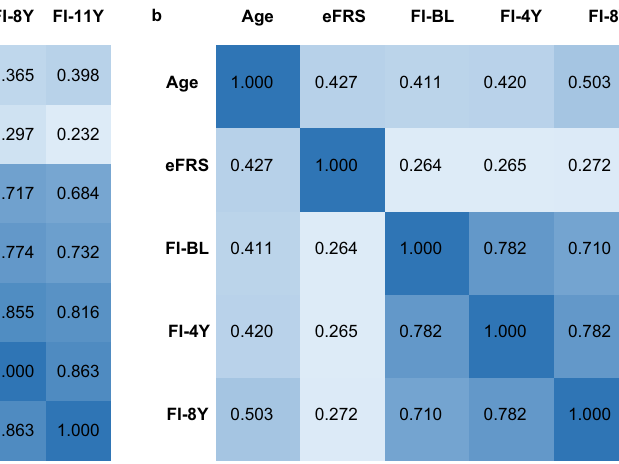
Fig. 1 | Spearman correlation coef fi cients of age, epigenetic frailty risk score and frailty index at baseline and various follow-up times. All P -values<0.001 (two-sidedwithoutadjustments). a subsetIII(ESTHERstudy); b subsetIV(KORA-Age